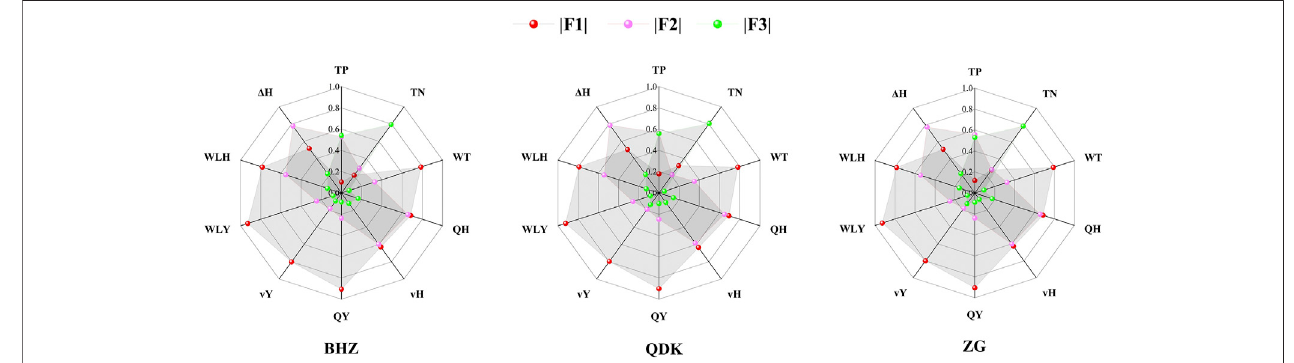
FIGURE 4 | Absolute value of principal component score for each variable at the three sample